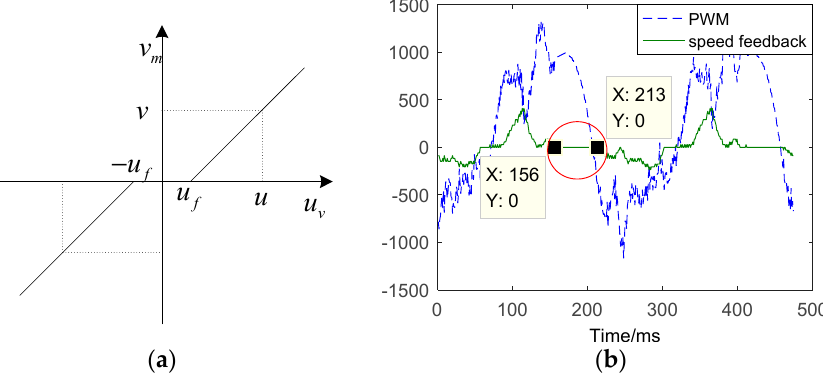
Figure 4. The effect of friction. ( a ) Characteristic of friction. ( b ) The tracking results of time-delay between speed feedback and PWM.